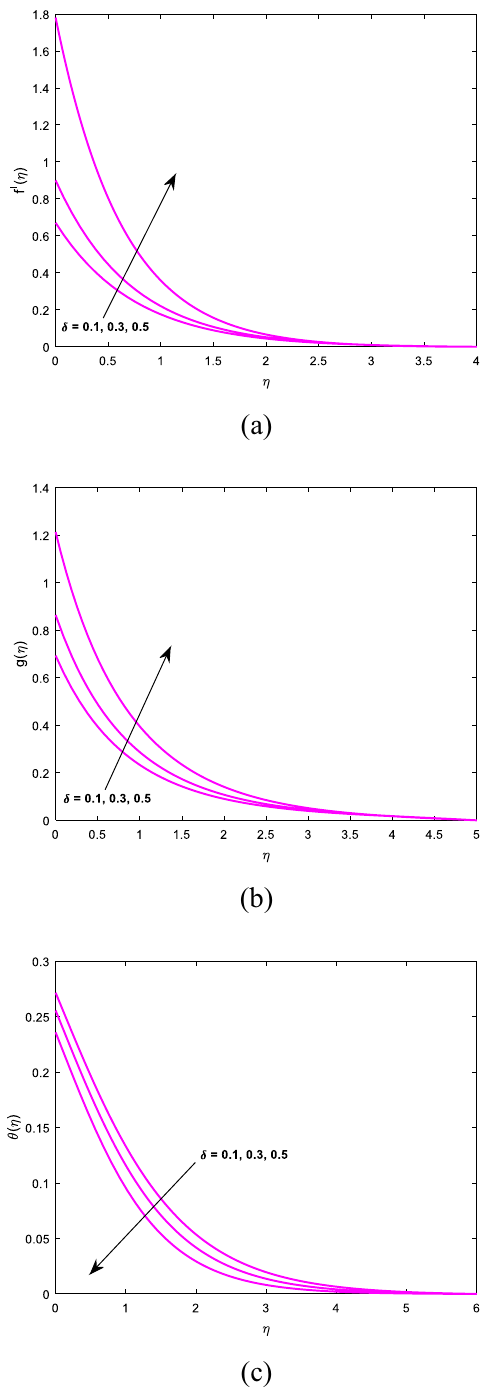
Figure 6. Impact of δ on ( a ) velocity ( b ) microrotation ( c )